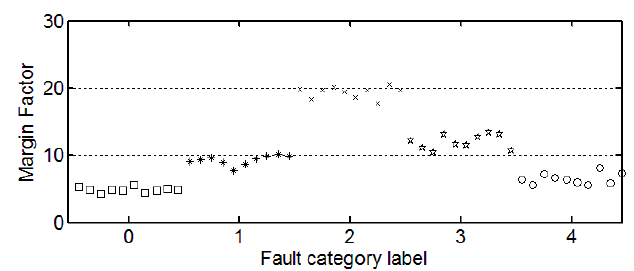
Figure 5. The trend of impulse factor.